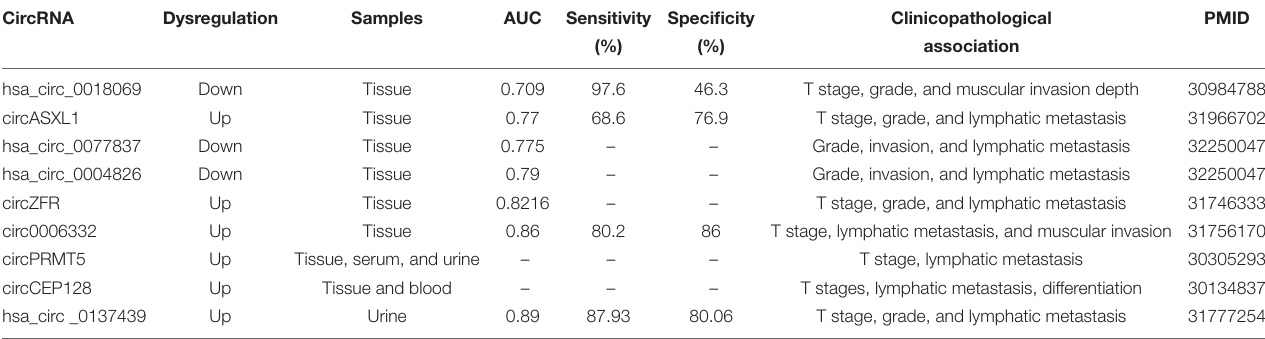
TABLE 2 | The potential circRNA as diagnostic biomarkers in bladder cancer.